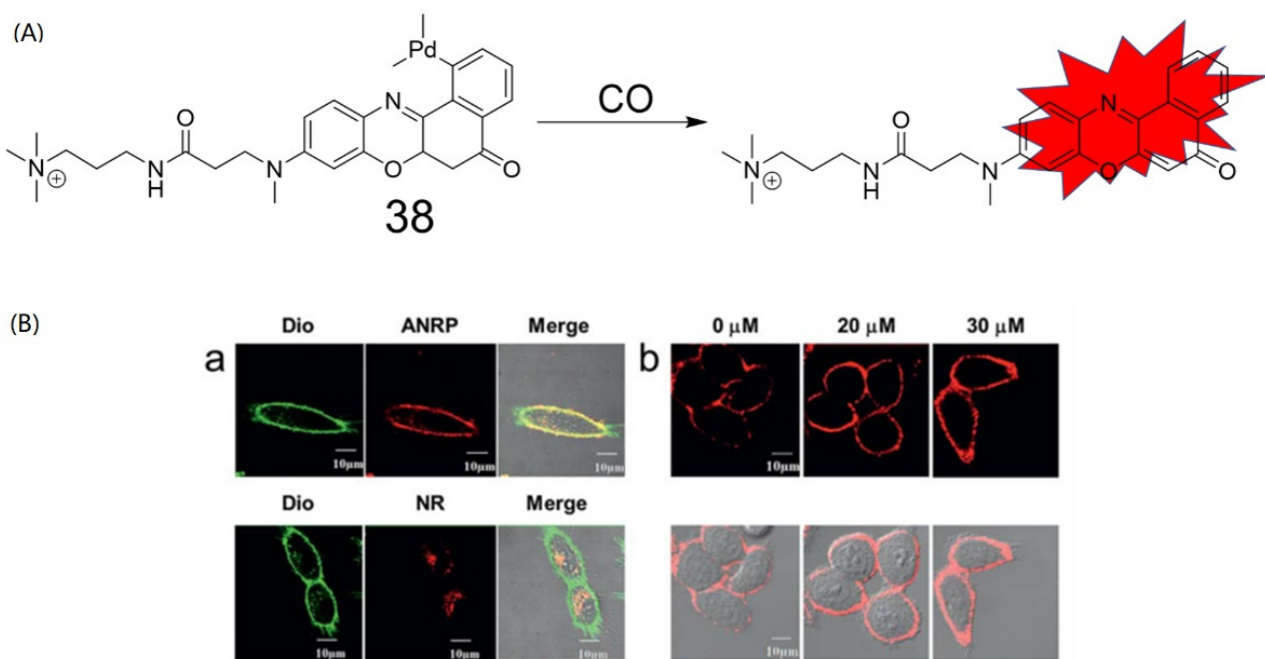
Figure 14. ( A ). The principle of probe 36 for the detection of CO. ( B – D ). Fluorescence imaging of probes to detect exogenous CO in cells, zebrafish and mice. Copyright (2017) Angewandte Chemie [47].